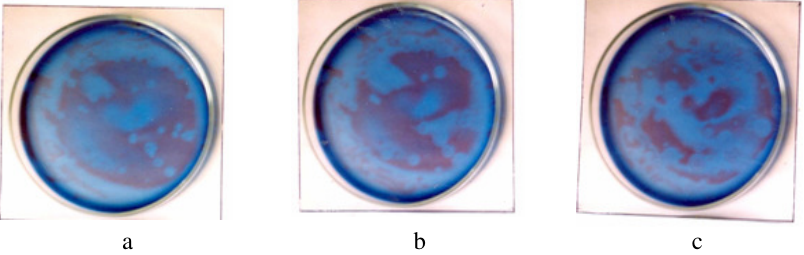
Figure. 1 . Fast appearing pattern up to 3 minutes.